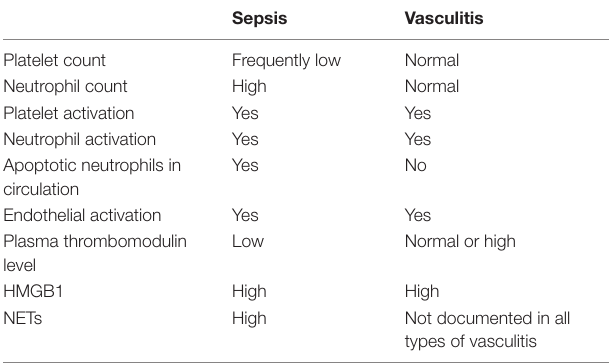
TABLe 1 | Comparison of some features of vascular inflammation in sepsis and ANCA-associated small-vessel systemic